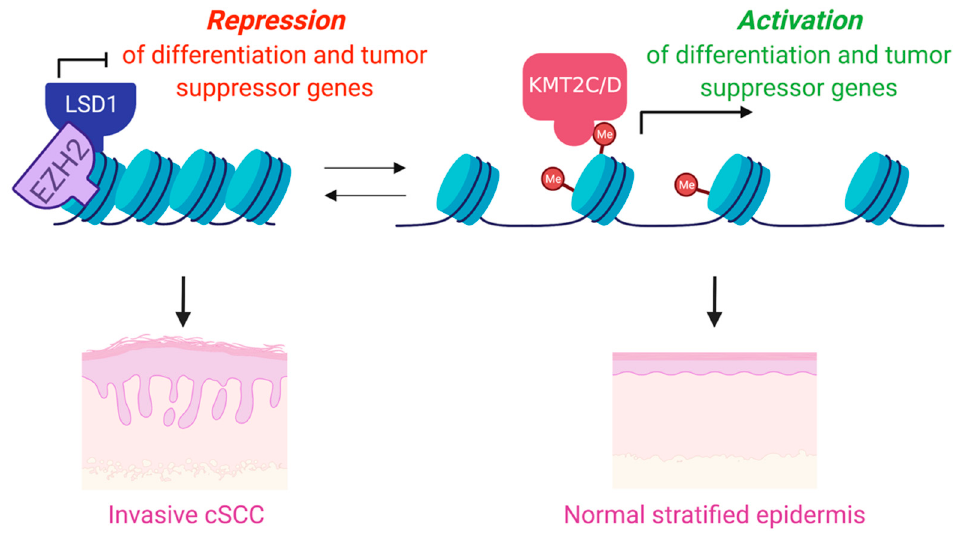
Figure 2. While the H3K4 methyltransferases have been shown to play roles in the promotion of differentiation and tumor suppression in the epidermis, the demethylases have been shown repress differentiation and are frequently overexpressed in KCs.